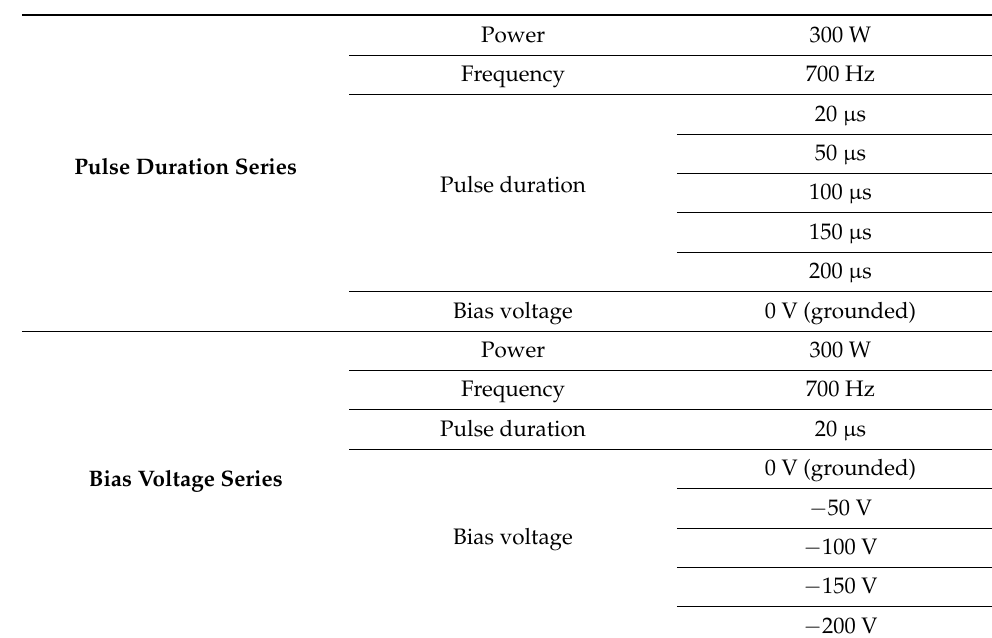
Table 1. Process